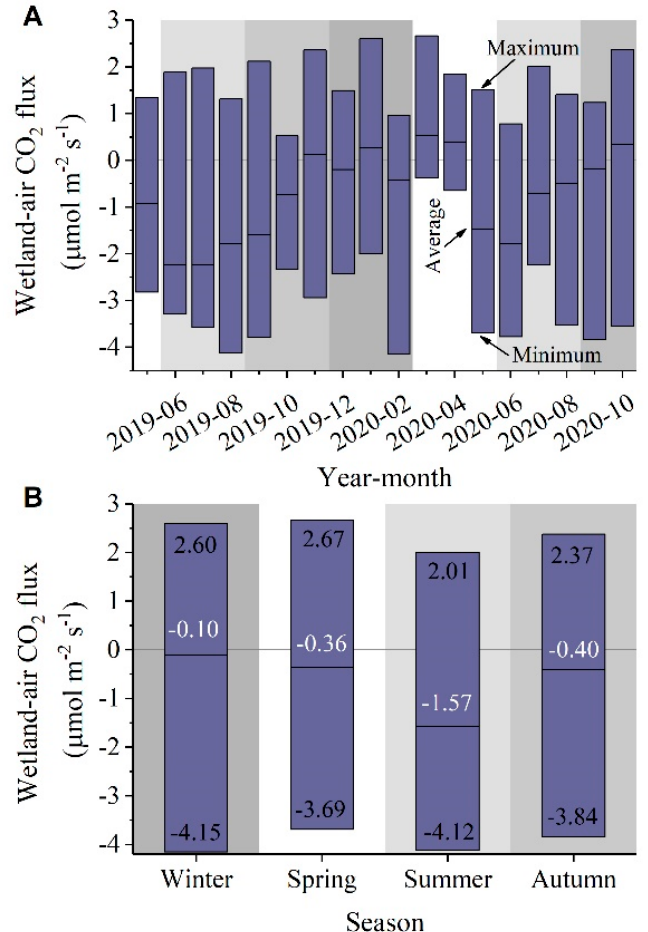
Figure 5. ( A ) Monthly average and ( B ) seasonal statistics of the daily wetland-air CO 2 exchange fluxes, the level of shading indicates the different seasons: from light to dark represents spring, summer, autumn, and winter.